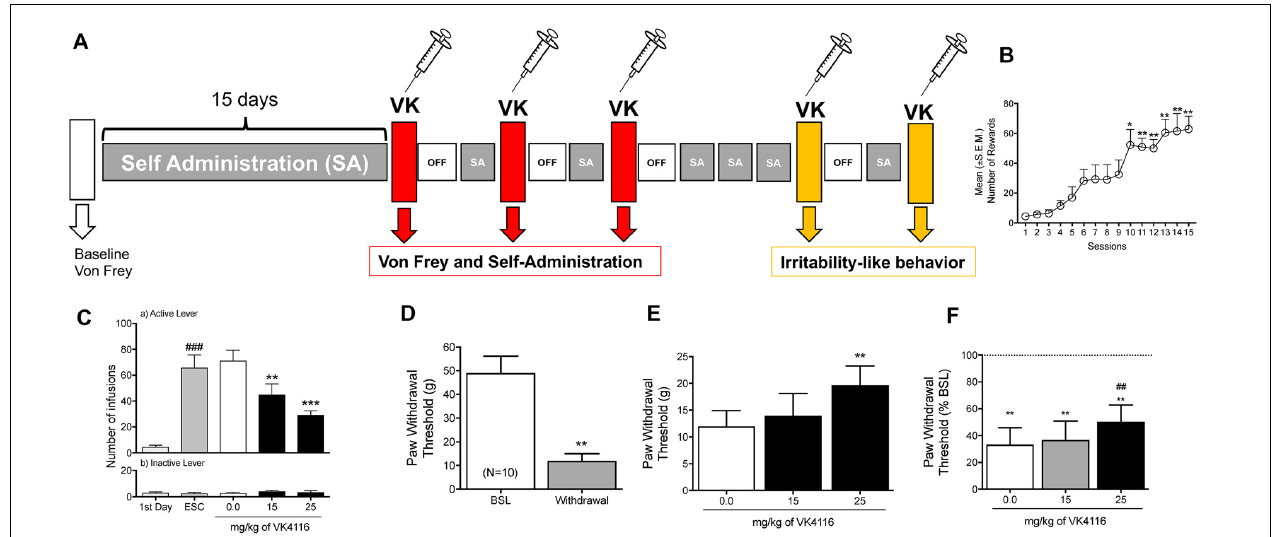
FIGURE 4 | (A) Schematic diagram of the experiment. (B) Escalation of oxycodone intake in HS rats. ∗ p < 0.05, ∗∗ p < 0.01, vs. day 1. (C) Effect of VK4116 in HS rats (within-subjects design). The upper panel (a) represents responses at the active lever. The lower panel (b) represents responses at the inactive lever. ∗∗ p < 0.01, ∗∗∗ p < 0.001, vs. 0 mg/kg; ### p < 0.001, vs. first day of oxycodone self-administration. (D) Development of mechanical hyperalgesia after the escalation of oxycodone self-administration in HS rats. ∗∗ p < 0.01, vs. baseline (BSL). (E,F) Effect of VK4116 on oxycodone withdrawal-induced hyperalgesia. The data are presented as grams of force applied. (E) ∗∗ p < 0.01, vs. 0 mg/kg and as a percent change from baseline pre-oxycodone. (F) ∗∗ p < 0.01, vs. BSL; ## p < 0.01, vs. 0 mg/kg.